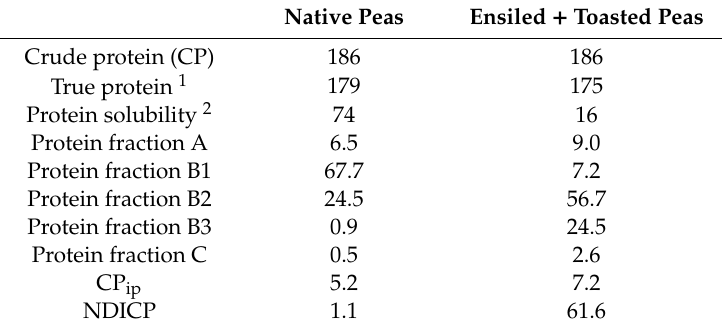
Table 4. Crude protein composition of the field pea treatments. Native Peas